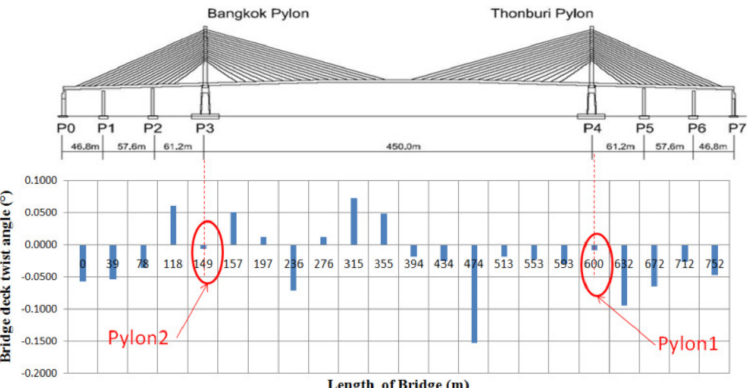
Figure 12. Measured twist angles of bridge by